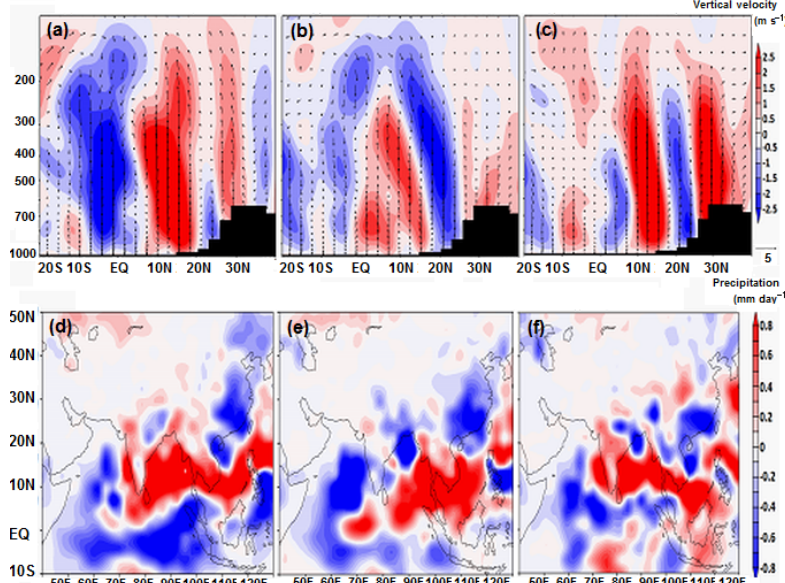
Figure 9. Difference in the meridional circulation due to enhanced NO x emissions averaged for the monsoon season (June–September) and over 70–100 ◦ E for (a) Ind38-CTRL, (b) Ind73-CTRL, and (c) Chin73-CTRL simulations. Shaded contours indicate the anomalies in vertical velocity (ms − 1 ). The vertical velocity field has been scaled by 300. Precipitation anomalies (mmday − 1 ) averaged for the monsoon season (June–September) obtained from (d) India38-CTRL, (e) Ind73-CTRL, and (f) Chin73-CTRL